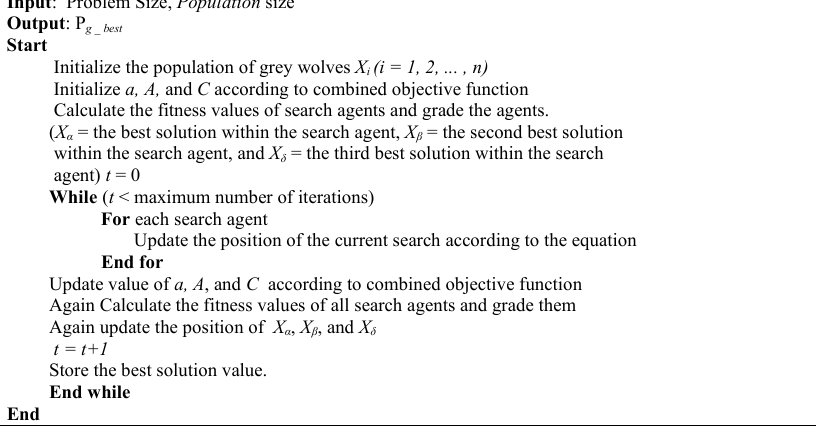
Fig. 2. Pseudo-code of grey wolf optimization algorithm